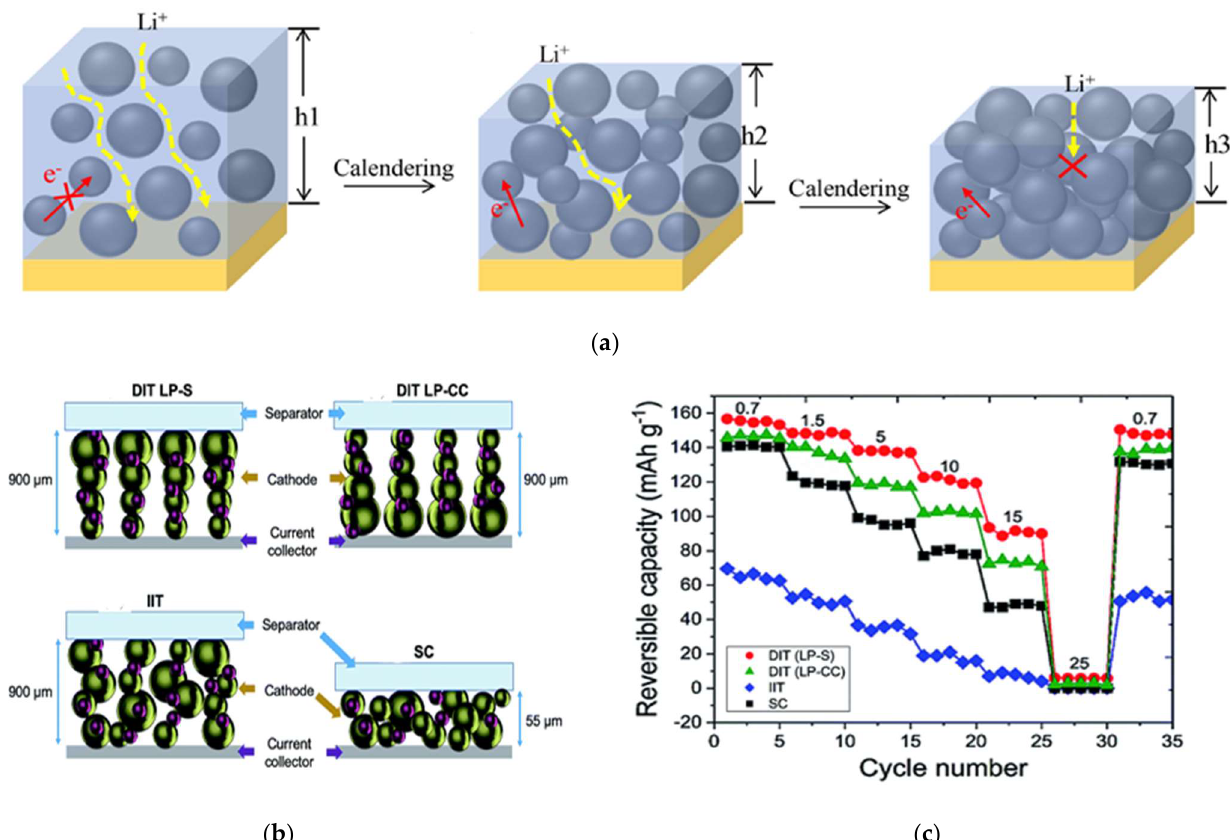
Figure 8. ( a ) The charge transport in electrodes with different porosity [48]. ( b ) Schematics of the four electrode types fabricated for performance comparison: (i) directional ice templating with low porosity nearest the separator (DIT LP−S); (ii) directional ice templating with low porosity nearest the current collector (DIT LP−CC); (iii) isotropic ice templating (IIT); and (iv) slurry casting (SC) [86]. ( c ) Reversible capacities of the four types of these electrodes at different current densities [86].